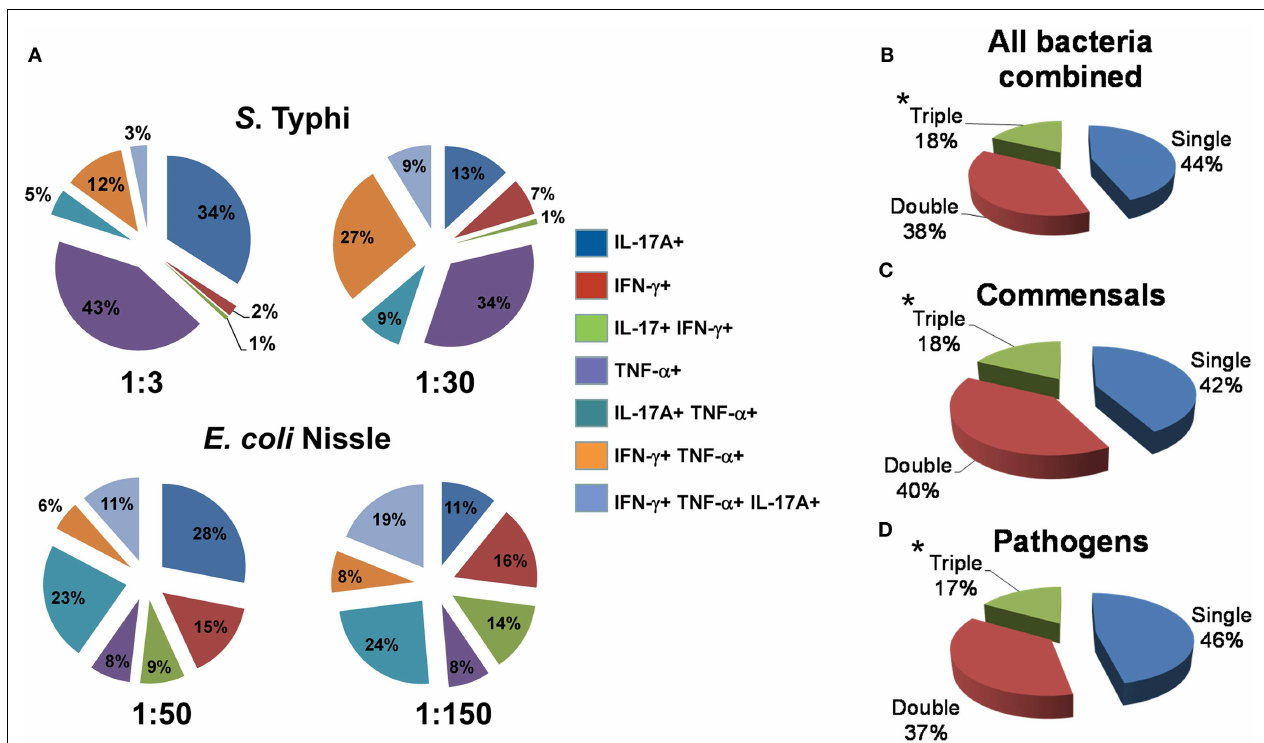
bacteria ( S. typhi , EPEC, or EIEC). Regardless of the type of stimulator cells, statistical differences were found only between MAIT cells secreting 1 (single) or 2 (double) vs. 3 (triple) cytokines. * p Values of < 0.05 were considered statistically significant. No statistical differences were found among the three pie charts: (B) MAITs exposed to any bacteria-infected-cells (i.e., commensal or pathogenic), (C) MAITs exposed to cells infected with commensal bacteria, and (D) MAITs exposed to cells infected with pathogenic bacteria. Comparisons between groups were performed using Kruskal–Wallis OneWay Analysis ofVariance on Ranks. Data are representative of five